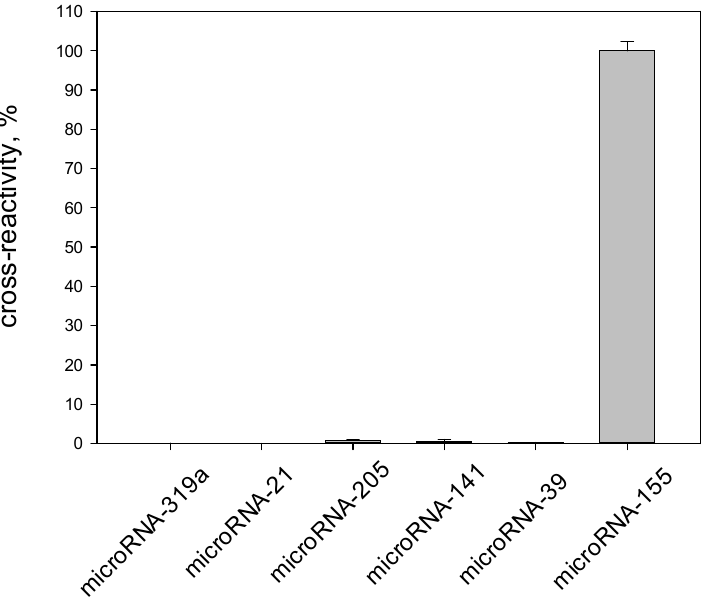
Figure 7. Specificity of the chemiluminescence heterogeneous method for the determination of microRNA-155 based on mismatched catalytic hairpin assembly amplification (n = 3). The concen- tration of the studied microRNAs was 100 pM.